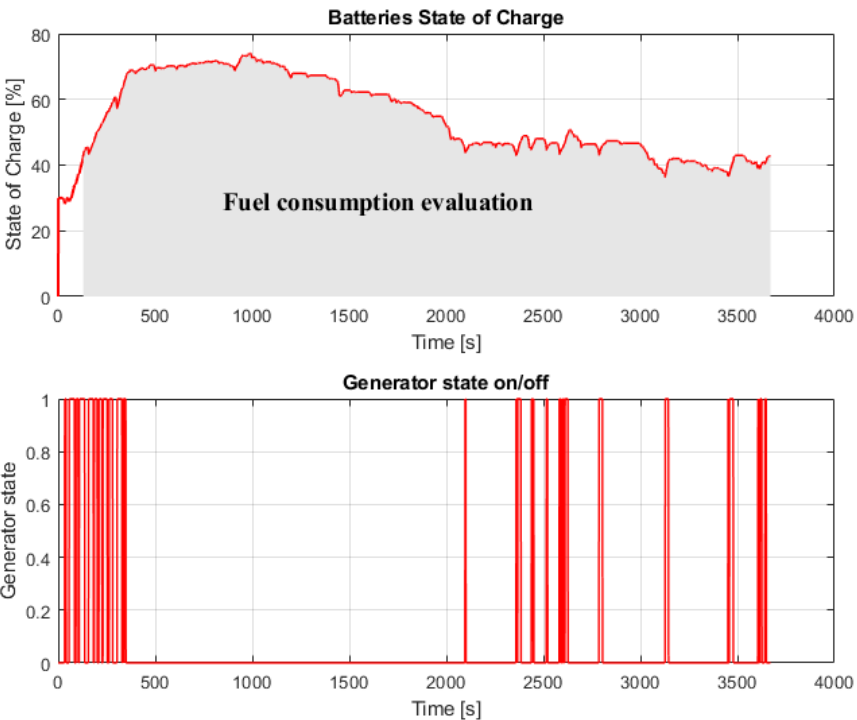
Figure 12. State of charge of the batteries and generator state (1 on, 0 off). Highlighted, the time laps considered for the fuel consumption evaluation.